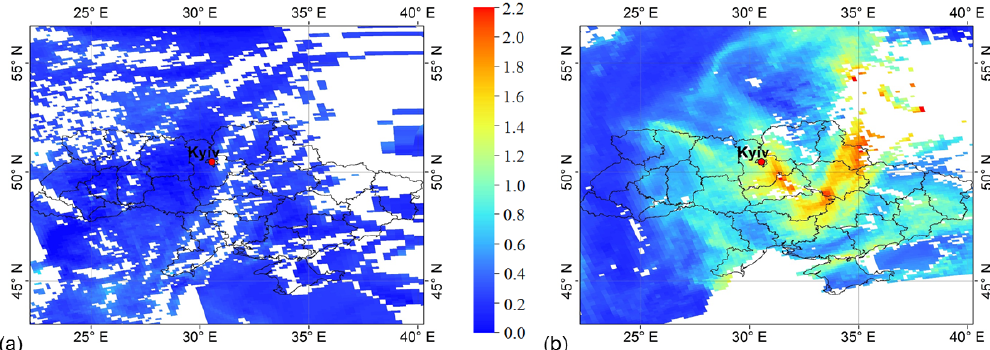
Figure 7. AOD 550nm distribution from Aqua MODIS measurements on 17 July (a) and 15 August (b)